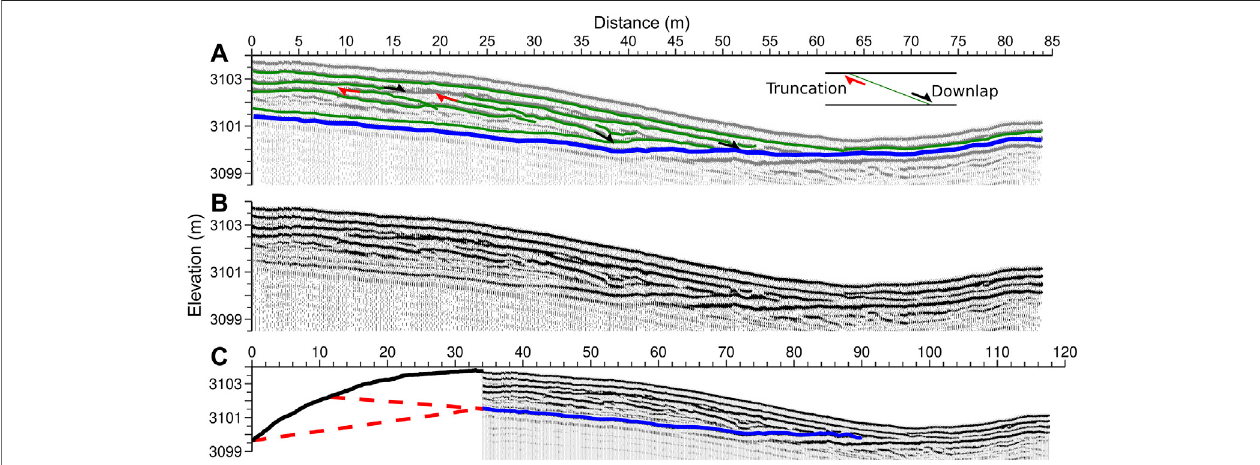
FIGURE4| ( A ) Longitudinal GPR transects ofthedepositionallobe ofBlowoutB. Thevertical axis isexaggerated by afactor of2.5. The extracted base isdenoted by the thicker blue line and interpretations of the internal bounding surfaces are shown by thinner green lines. ( B ) The uninterpreted GPR survey is shown for reference. ( C ) The extrapolations used to calculate volume estimates for the lobe of Blowout B. The interpreted base of the lobe is shown in the solid blue line. The solid black line shows the DEM surface. A linear model extrapolating the fi rst 10 m of the basal surface is shown in the higher red dashed line. The lower red dashed line shows a linear model between the start of the lobe and the identi fi ed